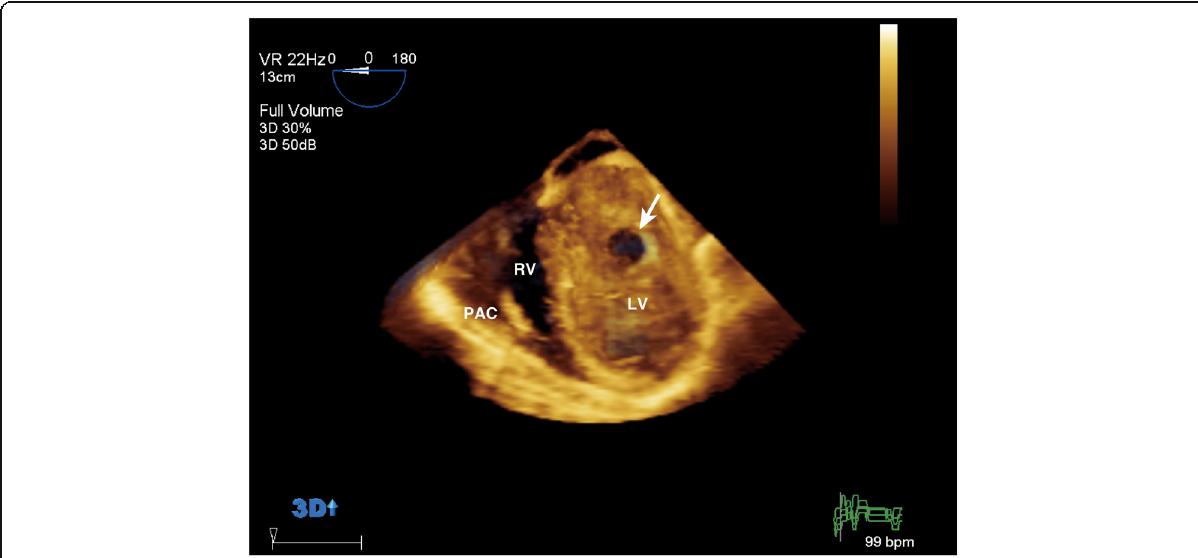
Fig. 2 Three-dimensional view of the orifice of the pseudoaneurysm from inside the LV (arrow). The orifice of the pseudoaneurysm was located in the inferior wall. This three-dimensional view clearly shows the shape of the orifice. LV left ventricle, PAC pulmonary artery catheter, RV right ventricle